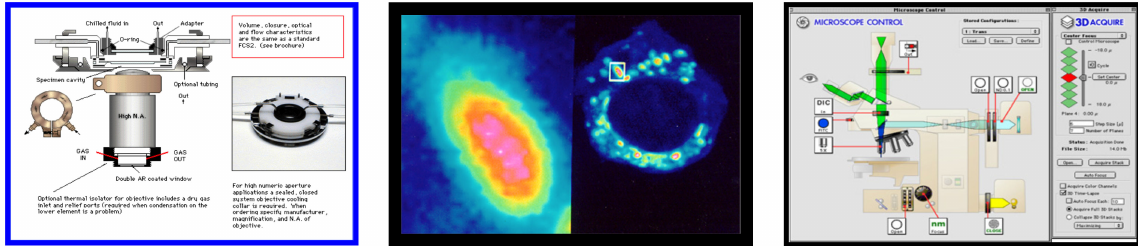
Figure 2. Quantitative imaging of plasma membrane and mitochondrial potentials in living cells. Left panel shows the live cell chamber we developed [10] to maintain the cells properly perfused, at strictly controlled temperatures, and allow fast addition of chemicals. The middle panel shows cellular (right) and (selected) mitochondrial (left) images, following Nernstian staining with TMRE. White box corresponding to center left image is 2 µ m × 2.5 µ m. Right panel highlights the 3D acquisition software and user interface